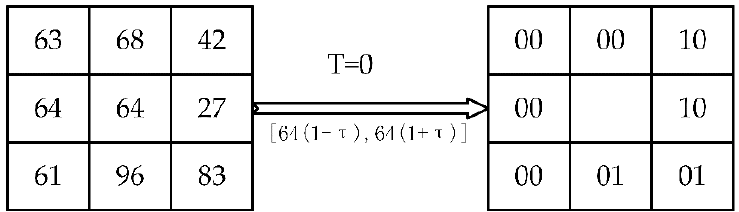
Figure 6. SILTP algorithm coding process.